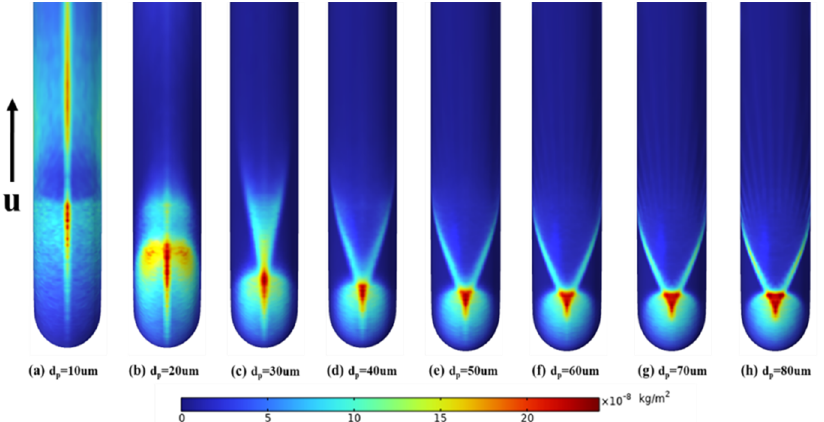
Figure 19. Erosion nephogram with different particle sizes.